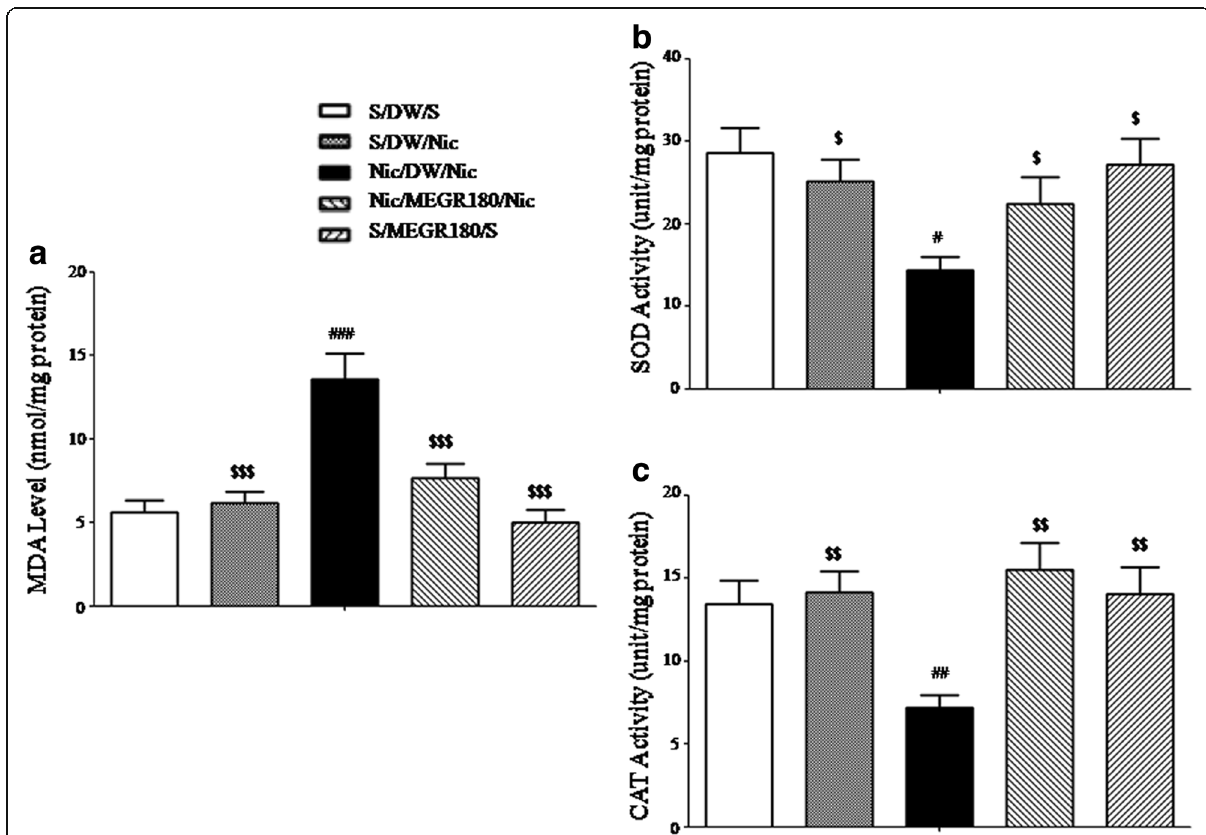
Fig. 3 Effects of MEGR on lipid peroxidation and antioxidant enzymes activities in the NaccSh. Immediately after the behavioral test, the a MDA levels and the activities of b SOD and c CAT in the NaccSh of the rats were measured using commercially available kits. All data are expressed as means ± SEM ( n = 4 – 5). Nic: nicotine, S: saline, MEGR: methanol extract of G. radix , MEGR180: 180 mg/kg/day MEGR once a day for 4